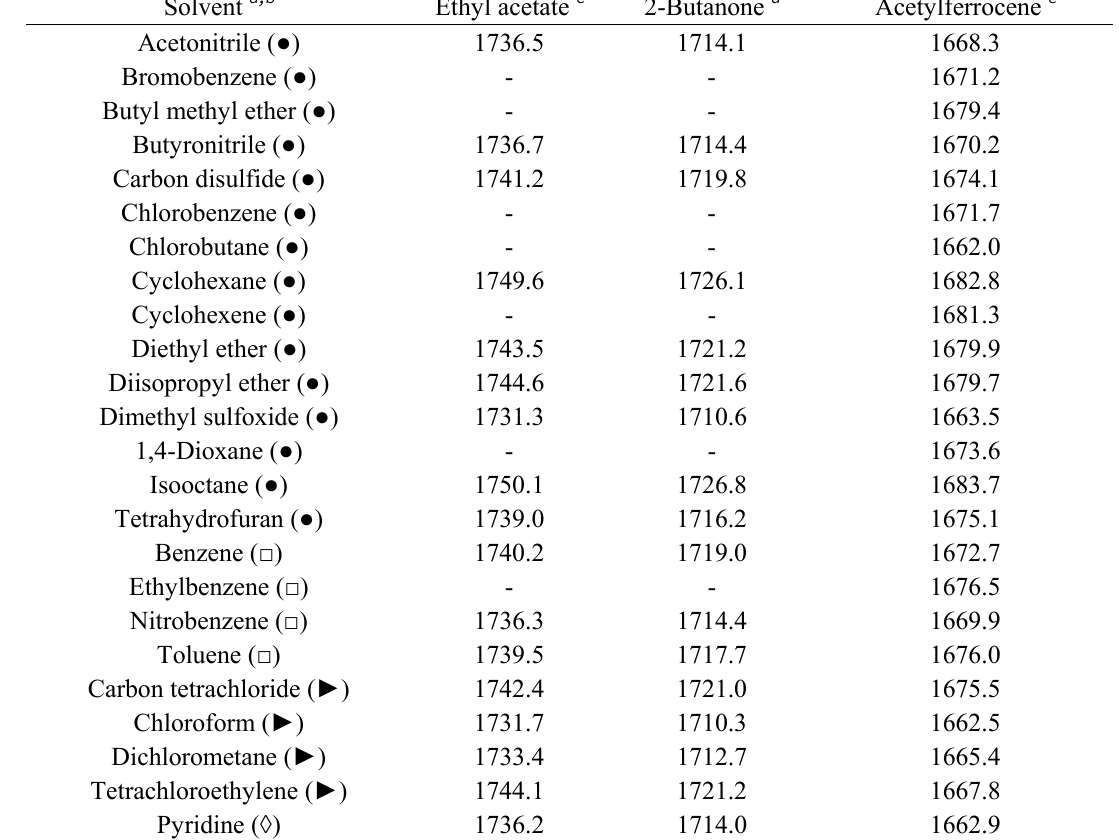
Table 2. Carbonyl IR absorption band (in cm -1 ) for acetylferrocene, 2-butanone and ethyl acetate in aprotic solvents at 298